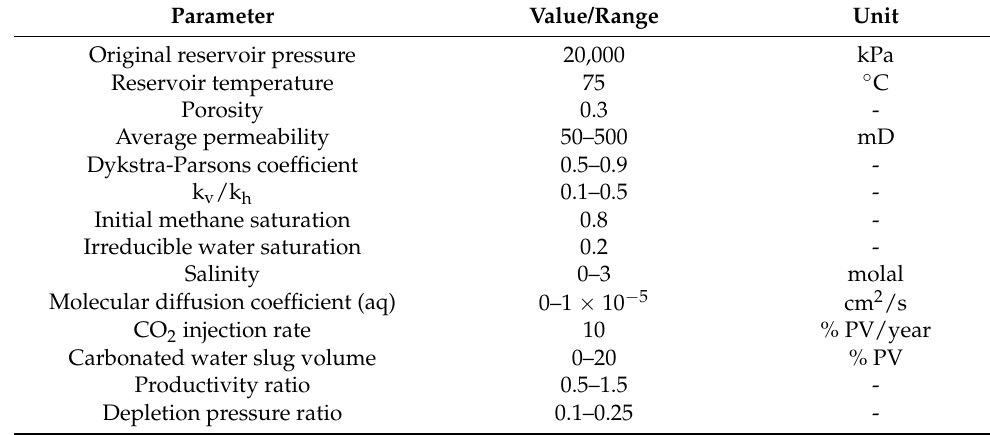
Table A1. Reservoir and operation parameters in the synthetic simulation model (values defined as ranges are parameters in the sensitivity analysis and uncertainty assessment).